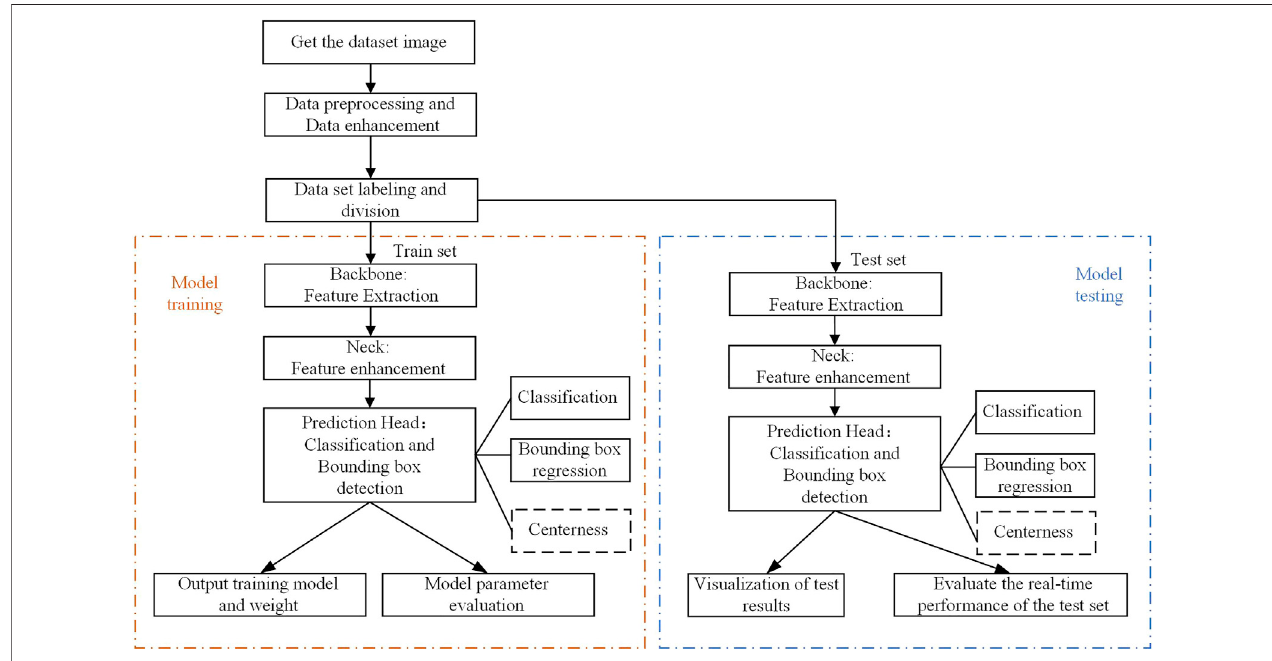
FIGURE 2 | The fl ow chart of the defect detection method proposed in this paper.